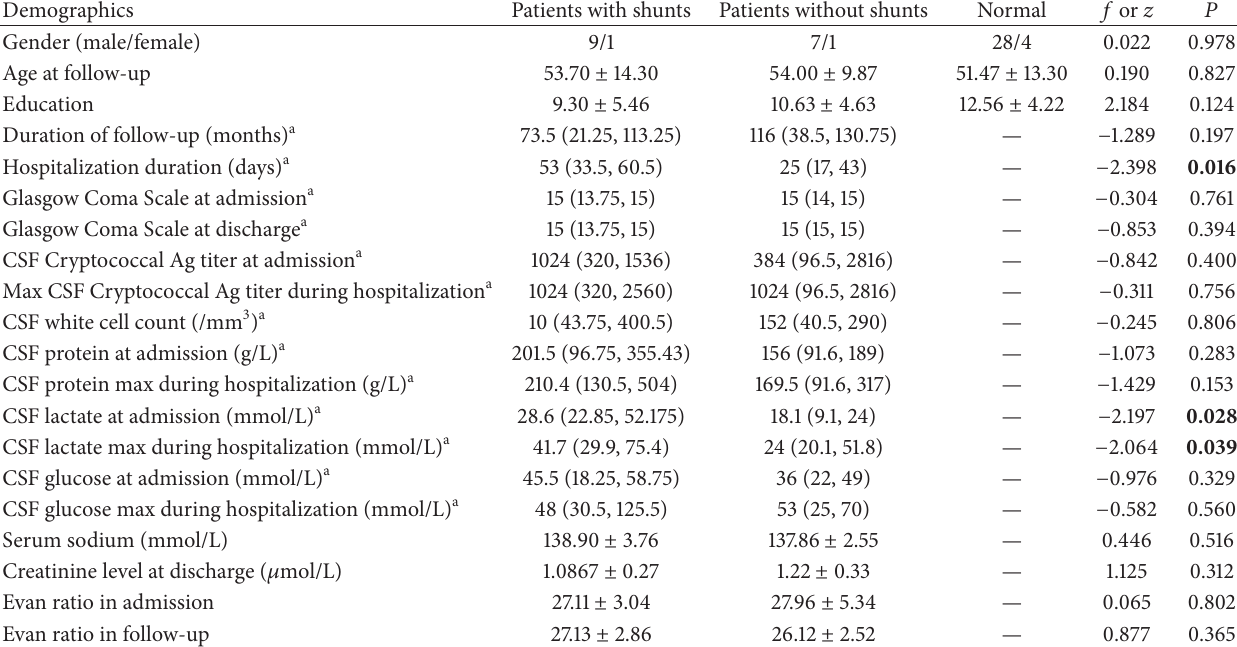
Table 1: Demographic data of cryptococcal meningitis patients and controls.